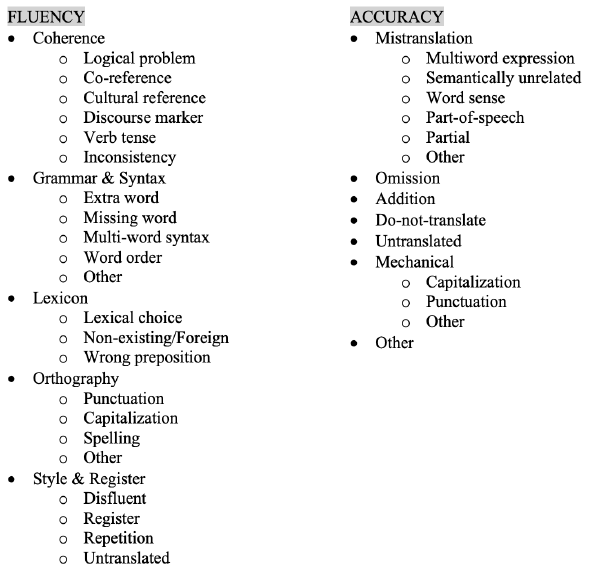
Figure 2. Overview of the SCATE error